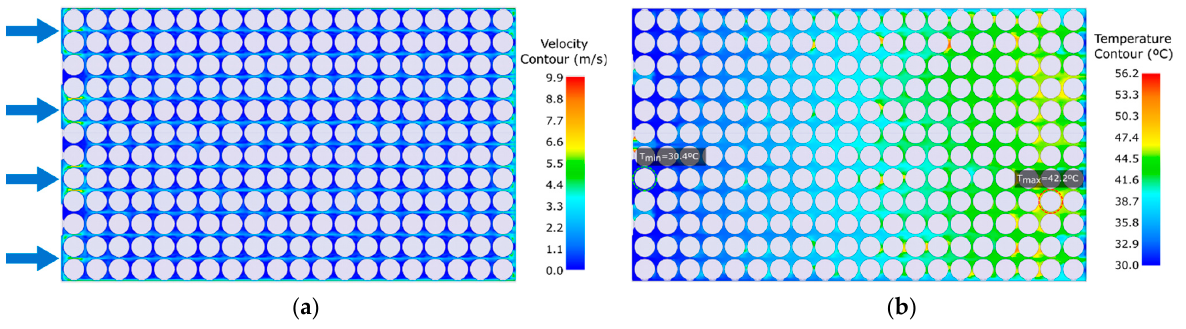
Figure 6. The contour of ( a ) velocity and ( b ) temperature of 4 inlet model. The air entered the battery pack through the inlet on the left side and exited through the outlet on the right side while taking the heat generated by the batteries in the process.